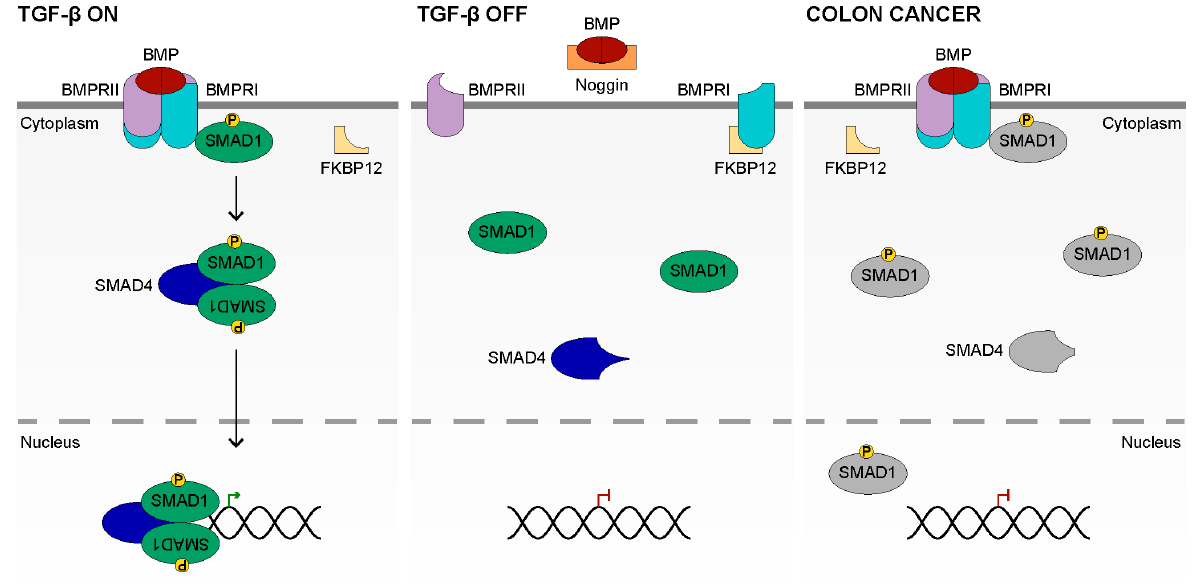
Figure 3. The TGF- β Signaling Pathway. In the TGF- β ON state ( left ), a BMP dimer binds to two BMPRI and two BMPRII to from a hetero-tetrameric complex. The Type II receptor phosphorylates the Type I receptor (not shown), which removes the inhibitory FKBP12 protein. An R-SMAD, such as SMAD1, binds the Type I receptor and is phosphorylated. The phosphorylated R-SMAD then forms a hetero-trimeric complex with SMAD4, the Co-SMAD and another SMAD1. The complex migrates to the nucleus where it binds the DNA and influences target gene expression. In the TGF- β OFF state ( center ), the BMP dimer is bound by Noggin which blocks binding to the Type II or Type I BMP receptors. The receptors remain unassociated, which prevents the phosphorylation of BMPRI. Therefore, BMPRI remains bound by FKBP12, which inhibits the phosphorylation of the R-SMAD. SMAD4 does not form a complex with the R-SMAD. In Colon Cancer ( right ), with a mutated SMAD4 , the BMP ligand remains capable of inducing hetero-tetramer formation and phosphorylation of the R-SMAD. However, the mutation inhibits formation of the Co-SMAD::R-SMAD complex and the R-SMAD and Co-SMAD is therefore in grey. SMAD1 may migrate to the nucleus alone, however the intended function of the Co-SMAD::R-SMAD complex is not performed.